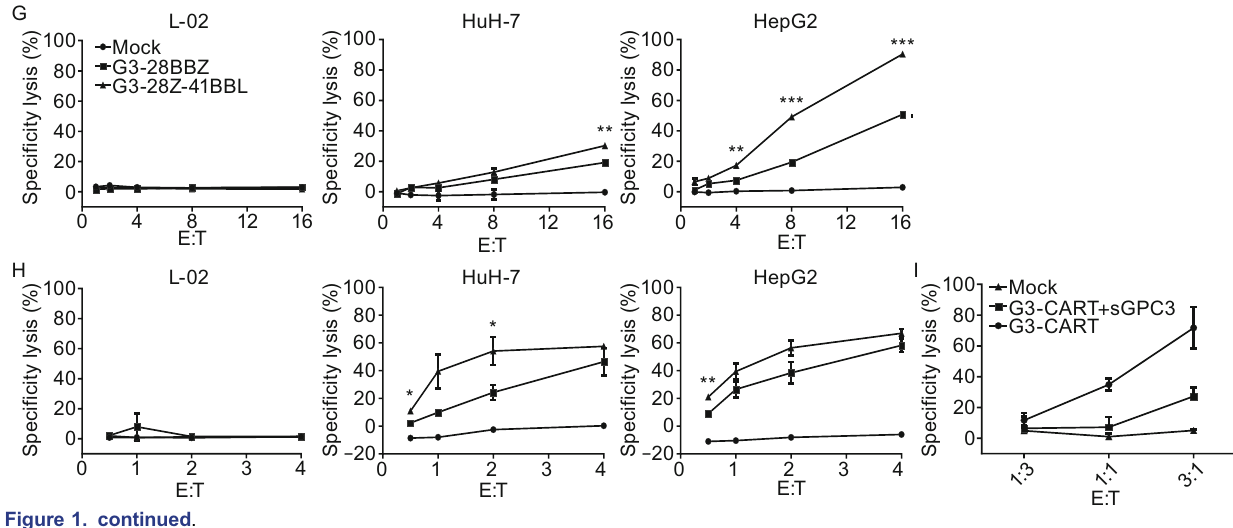
cells in vitro and in vivo as compared with G3-28BBz CAR-T cells (Fig. 2C and 2D). The potent antitumor activity of CD19- 28z-41BBL also was attributable to be the enhanced IFN β secretion (Zhao et al., 2015). To evaluate the in vivo therapeutic potential of GPC3 CAR-T cells, the highly immunode fi cient mice (NCG) were injected subcutaneously with 1 × 10 7 HuH-7 cells fol- lowed by injection of 1 × 10 7 G3-28BBz, G3-28z-41BBL, or mock T cells on day 14 i.v. By measuring the tumor dimen- sion every 3 or 4 days with calipers, GPC3 CAR-T cells signi fi cantly suppressed the growth of HuH-7 tumors and prolonged the mice survival in comparison to the mock group (Fig. 2E and 2F). The measurement of human CD3 + T cells in mice peripheral blood at 7, 14 or 21 days after the injection of T cells showed that the GPC3 CAR-T cells persisted for about three weeks and the amount of GPC3 CAR-T cells peaked at ∼ day 14 (Fig. 2G). Since we could not fi nd sig- ni fi cant differences between abilities of G3-28BBz and G3- 28z-41BBL to suppress tumor growth and to prolong mice survival, a ‘‘ stress test ’’ was run by decreasing the dose of GPC3 CAR-T cells by 10-fold to 1 × 10 6 cells/mouse. Although the tumor growth suppression is not observed because of the excessively decreased cell number, G3-28z- 41BBL prolonged the mice survival compared with G3- 28BBz and mock groups (Data not shown). For another optimized ‘‘ stress test ’’ , a middle dose of GPC3 CAR-T cells (3 × 10 6 cells/mouse) was injected, the growth of HuH-7 tumors were suppressed signi fi cantly as well as the high dose (Fig. 2H). Although G3-28BBz and G3-28z-41BBL CAR-T cells displayed a similar capability to inhibit the growth of tumor, the latter was signi fi cantly more effective in prolonging the survival of the tumor-bearing mice (Fig. 2I). had more robust proliferation (Fig. 2J).